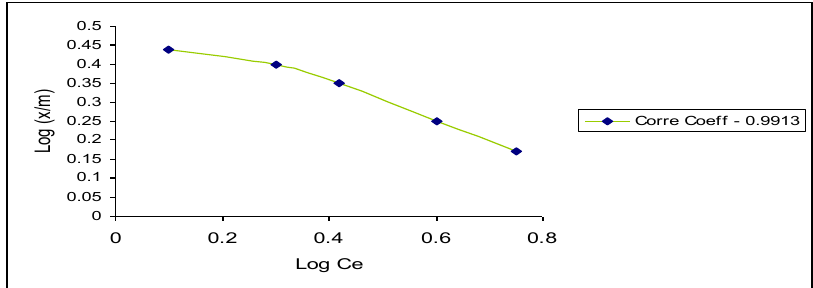
Figure 6 . Logarithmic relationship between adsorption and equilibrium adsorption. Adsorption Kinetics